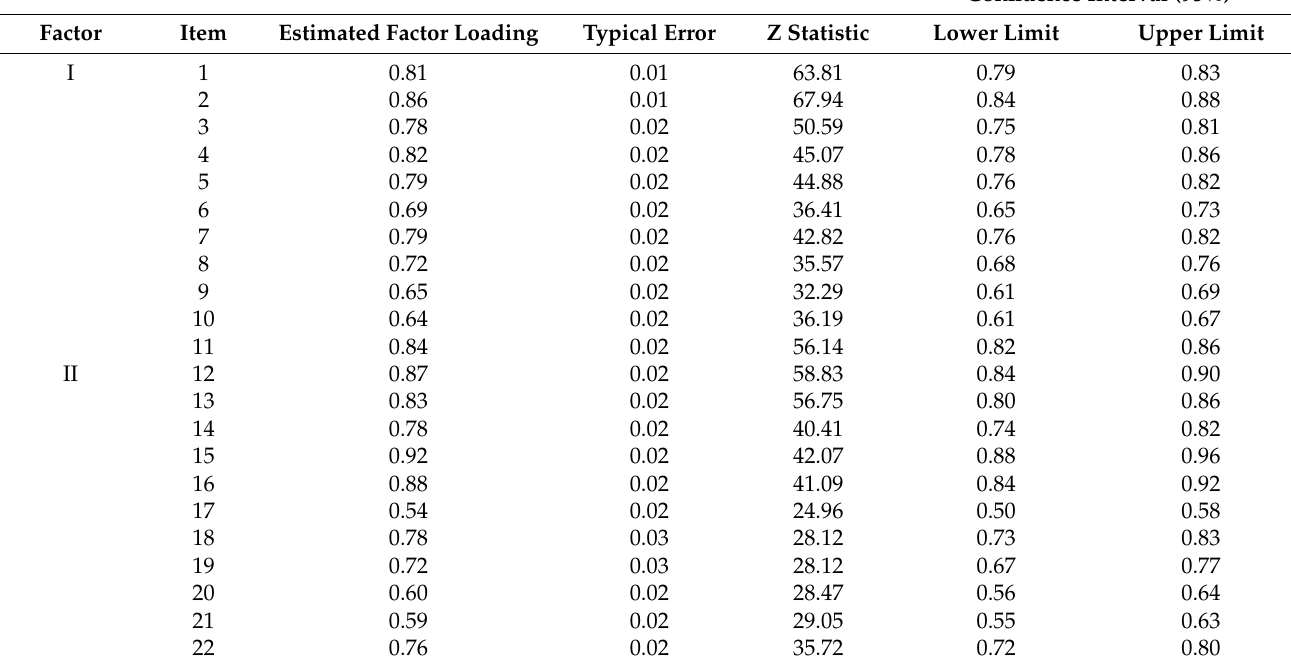
Table 2. Standardized factor loadings for the two-factor model of the European Cyberbullying Intervention Project Questionnaire.